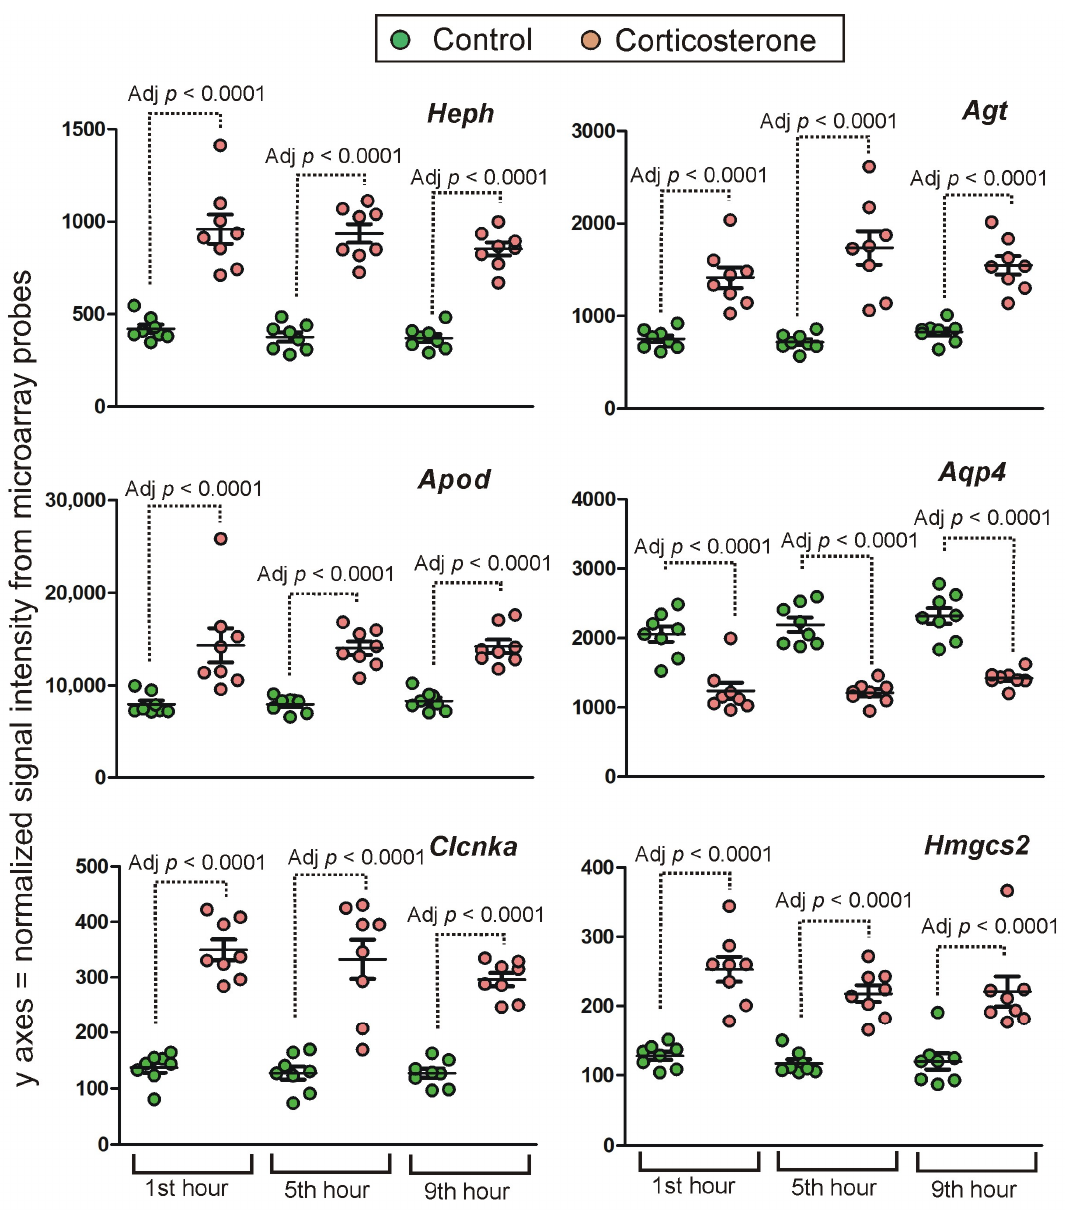
Figure 10. Examples of genes displaying long-lasting primary effects. Y axis indicates probe signal intensity decomposed into green and red channel after final background correction, within-array and between-array normalization. All data are available in File S1.